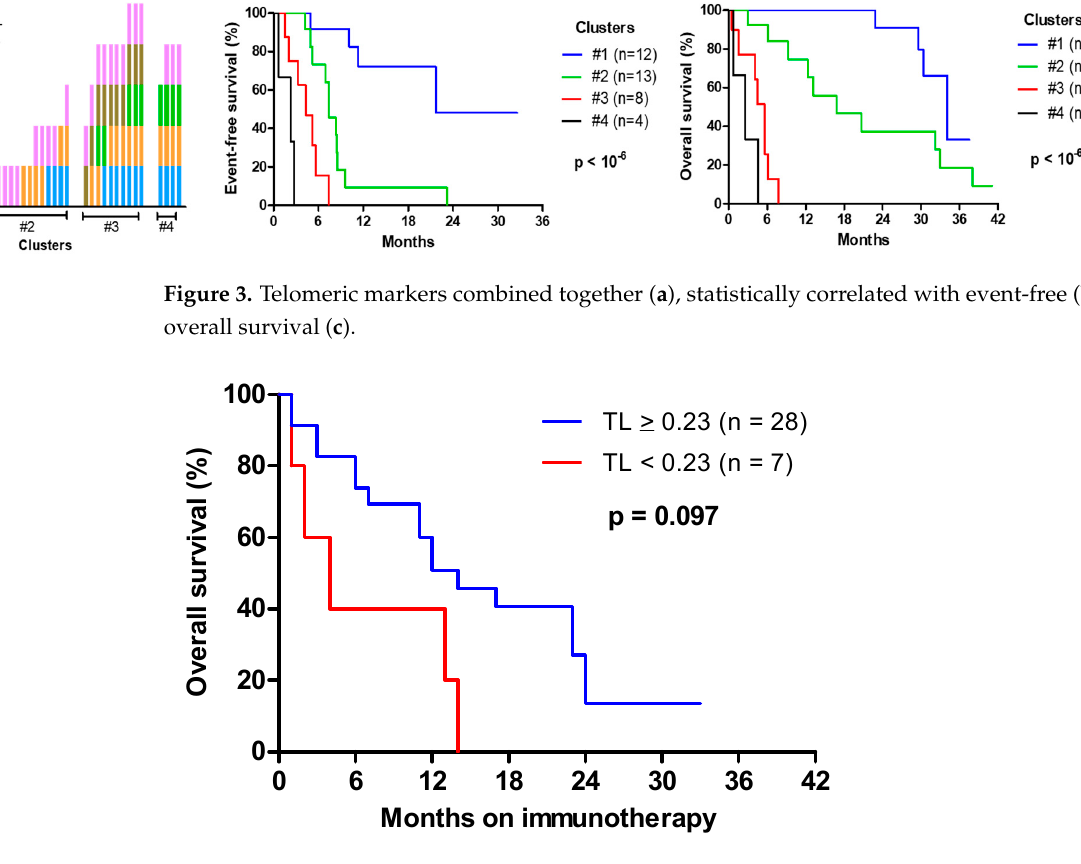
Figure 4. Overall survival from the date of the initiation of immunotherapy in advanced NSCLC as a function of telomere length.